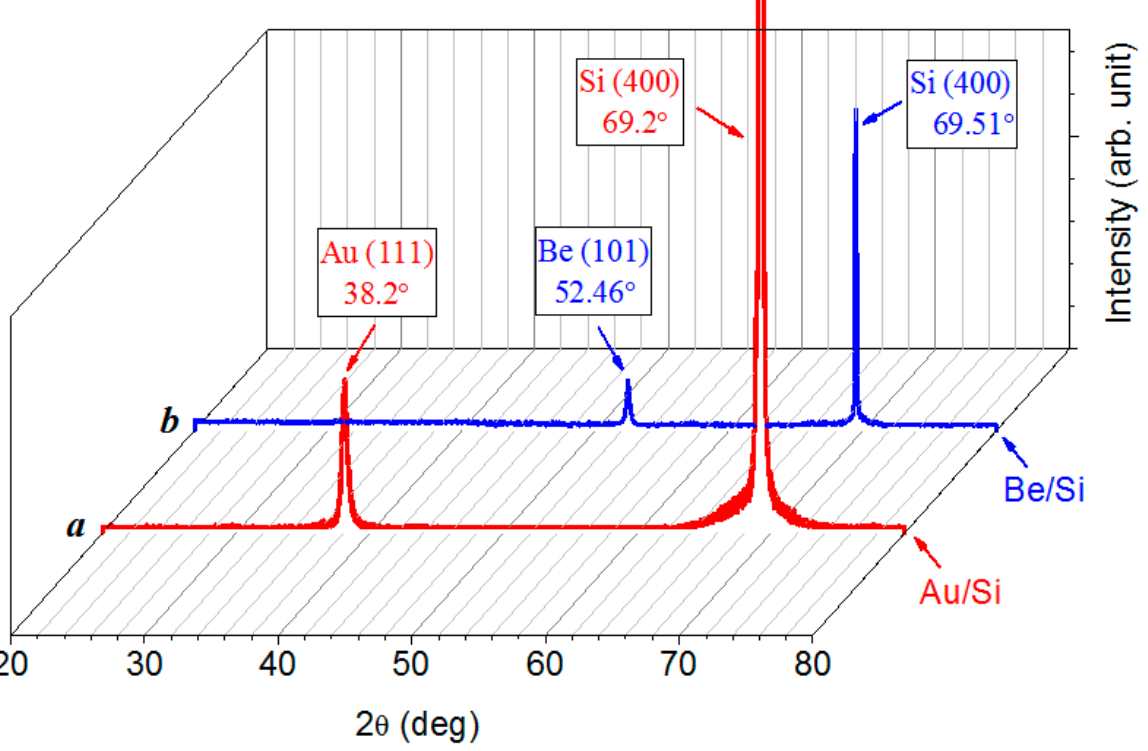
Figure 5. X-ray diffraction pattern of 90 nm-thick gold (a) and beryllium (b) films on silicon substrate obtained by tenfold repetition of deposition (60 s) and sputtering (30 s) processes.